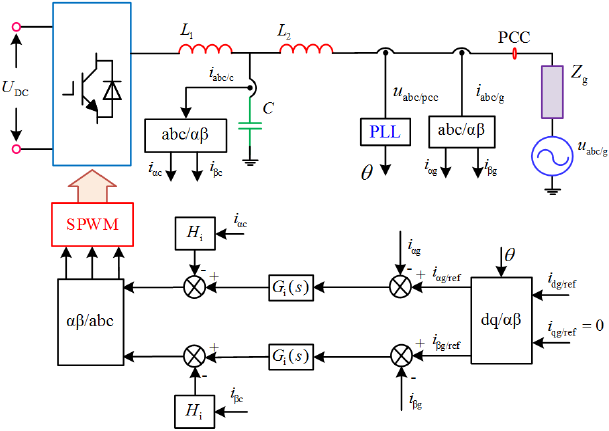
Figure 1. Topology and control structure of three-phase LCL-type grid-connected inverter. In Figure 1, U DC represents the input voltage on the DC side of the inverter; i abc/c represents the amount of three-phase capacitor current; u abc/c represents the amount of three-phase voltage at the PCC; Z g represents the equivalent grid impedance on the transmission line (because the resistance component in the grid impedance is beneficial to the stability of the inverter system, this article only considers the inductance part.); i abc/g represents the grid current value of the inverter; u abc/g represents the three-phase grid voltage; θ is the phase output value of the phase lock link; and i dg/ref and i qg/ref represent the current reference value in the dq-frame given by the power loop. In the case of the unity power factor, i qg/ref = 0, i dg/ref and i qg/ref undergo frame transformation to become the current reference value in the αβ -frame.